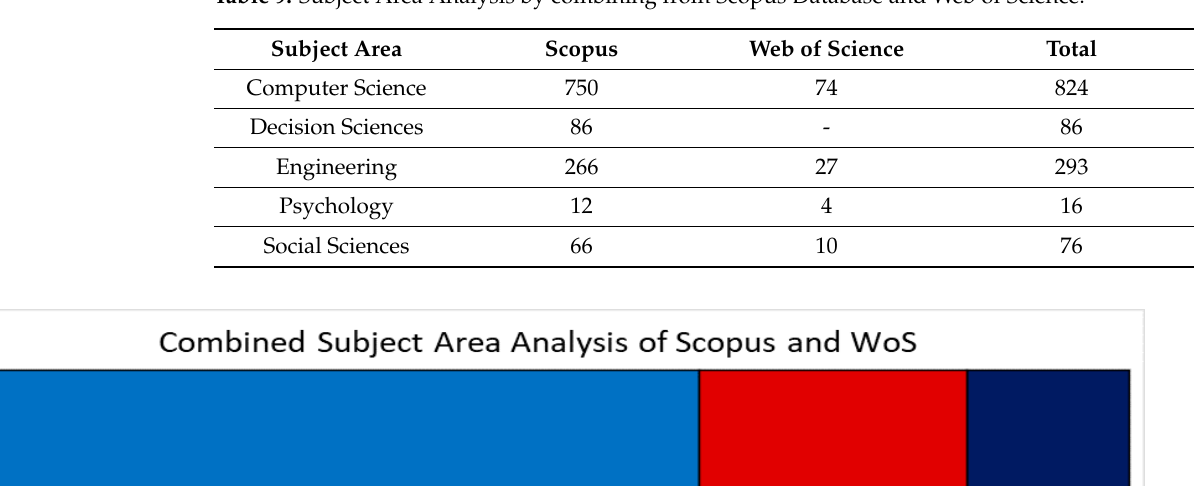
Table 9. Subject Area Analysis by combining from Scopus Database and Web of Science.